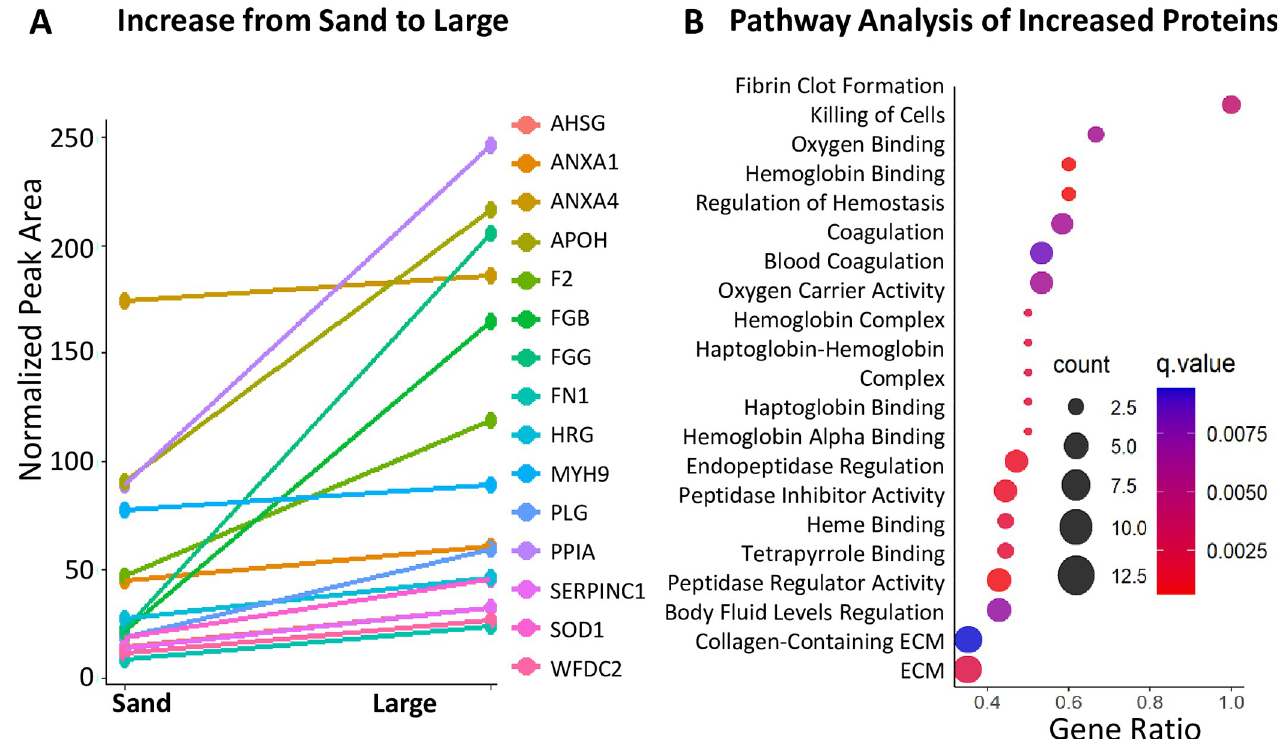
Fig 4. Pathway analysis of significantly changed proteins comparing large stones vs sand. (A) Among upregulated pathways and proteins in large stones ( when comparing large stones vs sand ), coagulation machinery and protease inhibitors are significantly increased. (B) There is also enrichment for coagulation- related pathways and hemoglobin binding and oxygen binding